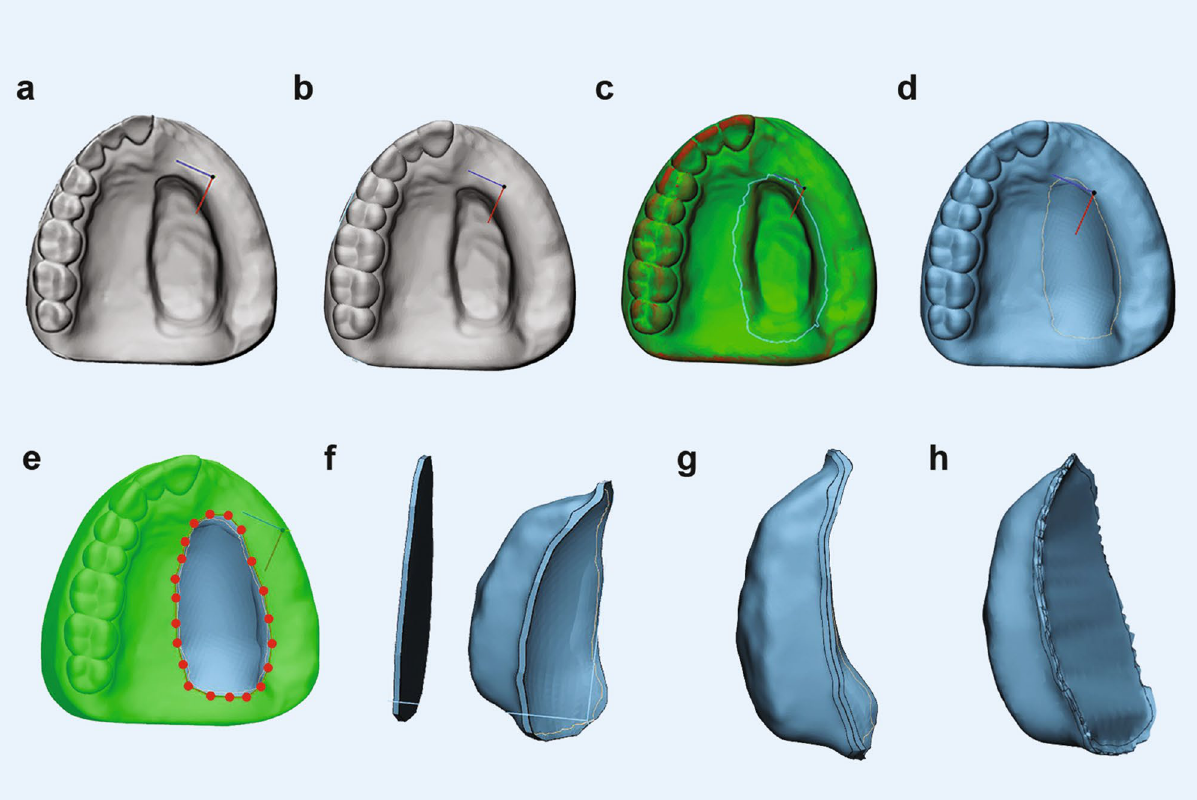
Figure 2. Design of bulbs using 3-matics ( a ) import STL, ( b ) make hollow, ( c ) design curve around defect, ( d ) reconstruct surface, ( e ) trim the reconstruction zone, ( f ) remove any excess mesh, ( g ) create chamfered margins, ( h ) wrap, smooth and export